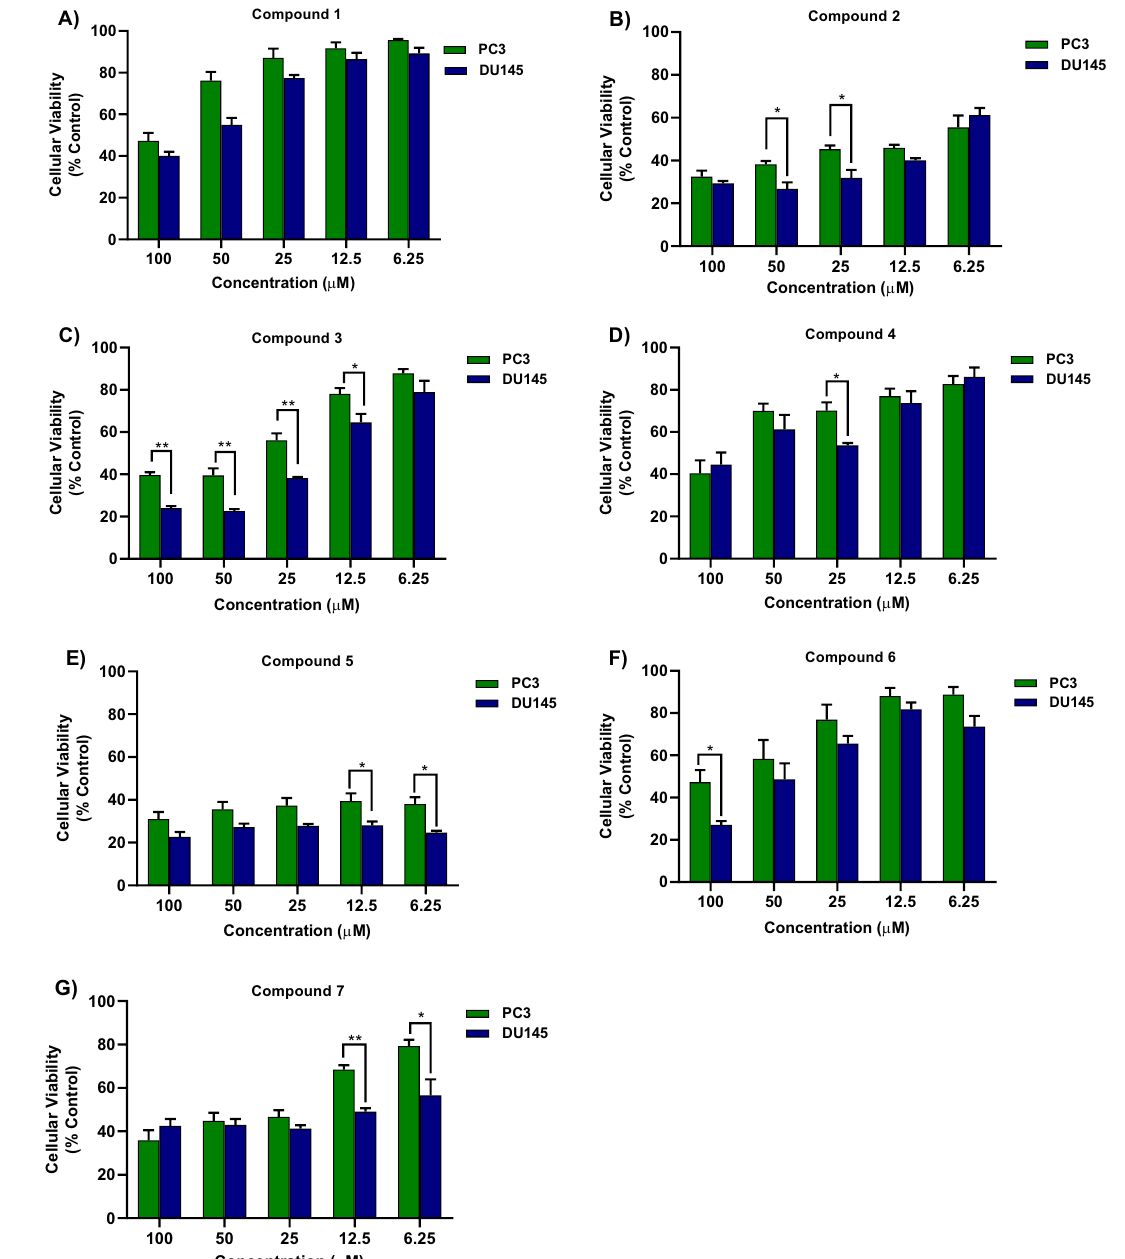
Figure 1. The antiproliferative activities of the seven 2,3-dihydroquinazolin-4(1 H )-one analogues (C1–C7) against PC3 (green) and DU145 (blue) cell lines. ( A – G ) refer to C1, C2, C3, C4, C5, C6 and C7, respectively. Significance between two cell line is expressed as * P -value ≤ 0.05, ** P -value ≤ 0.01 (Student’s independent ion chromatograms (TIC) of DU145 cells treated with C5, C6 or untreated control are presented in Fig. S3 in supplementary. Multivariate analysis. A total of 1628 mass feature ions were detected using LC–MS/MS analysis, of which 106 metabolites were identified. The unsupervised PCA model revealed a good clustering of the QC samples in the center of the PCA scores plot reflecting satisfactory stability and a valid analytical performance of the LC–MS/ MS run (Fig. 6A). Moreover, partial separation and clustering of the three sample groups was evident in the PCA scores plot pointing to the disturbing effect of the two treatments on the extracellular metabolites of the DU145 compared to untreated control group. To identify significantly altered metabolites upon treating DU145 cells with C5 or C6, supervised analysis using PLS-DA and OPLS-DA was performed (Fig. 6B–E). Each treatment group displayed a clear clustering and separation from the control group. OPLS-DA scores plots had satisfactory R2Y and Q2 values, and passed the